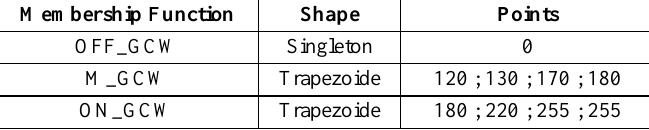
Table 10: Azimuthal moving engine member functions.